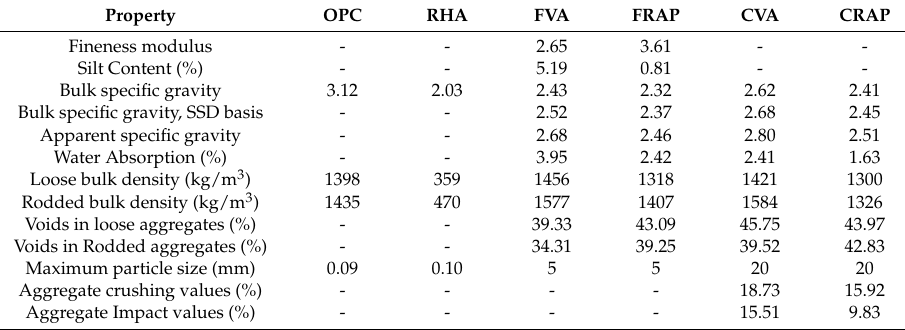
Table 3. Physical and mechanical properties of materials.